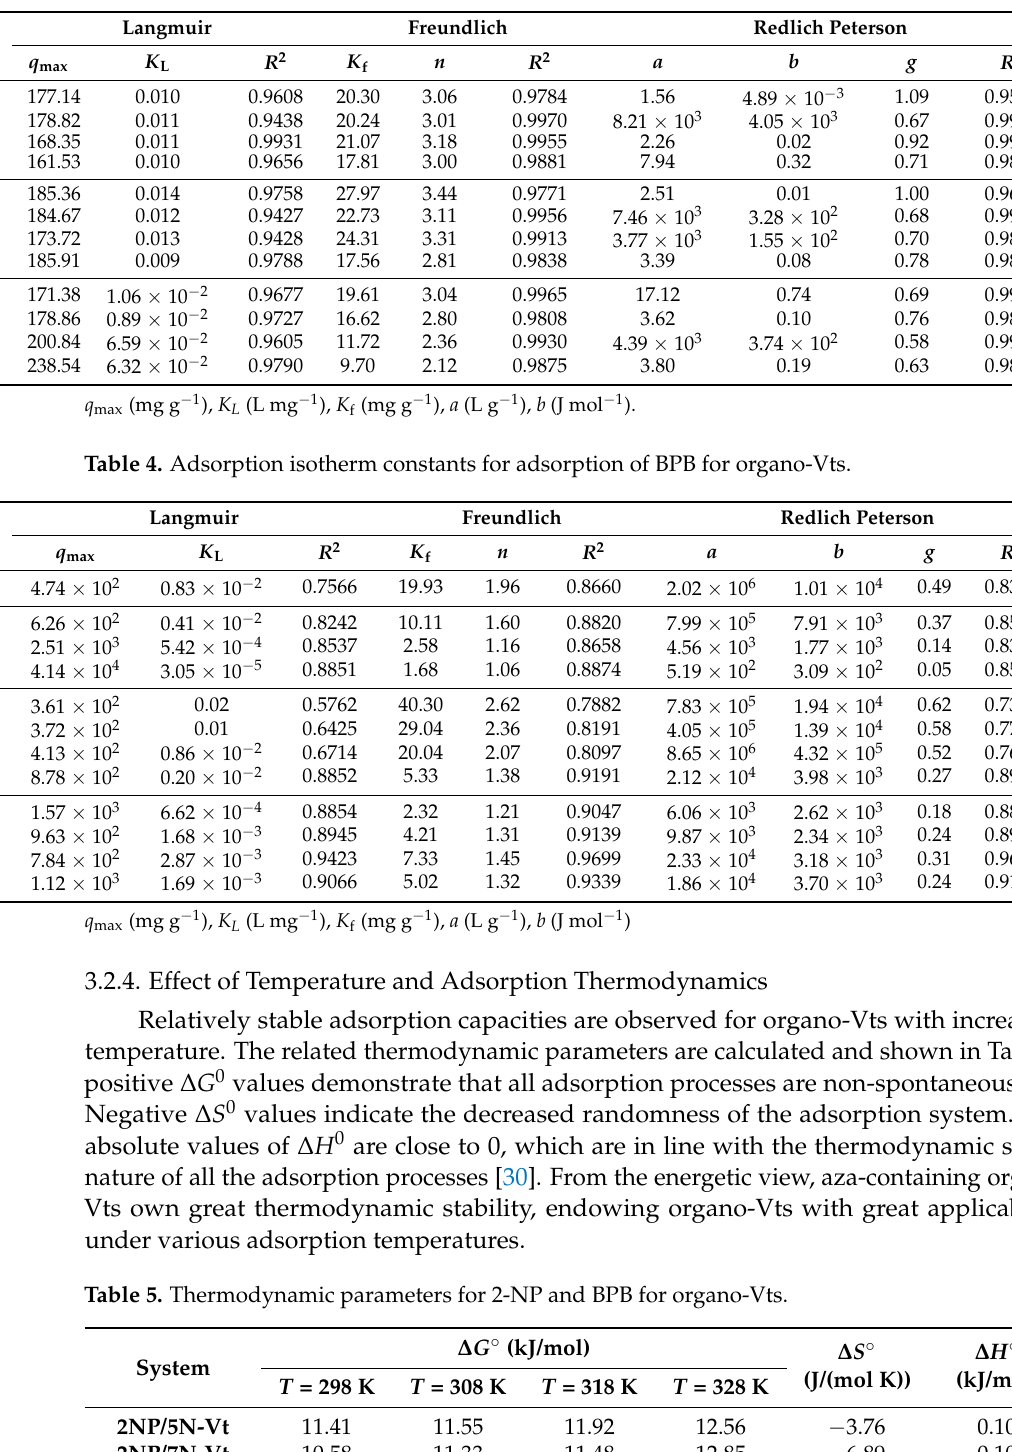
Table 3. Adsorption isotherm constants for adsorption of 2-NP for organo-Vts.